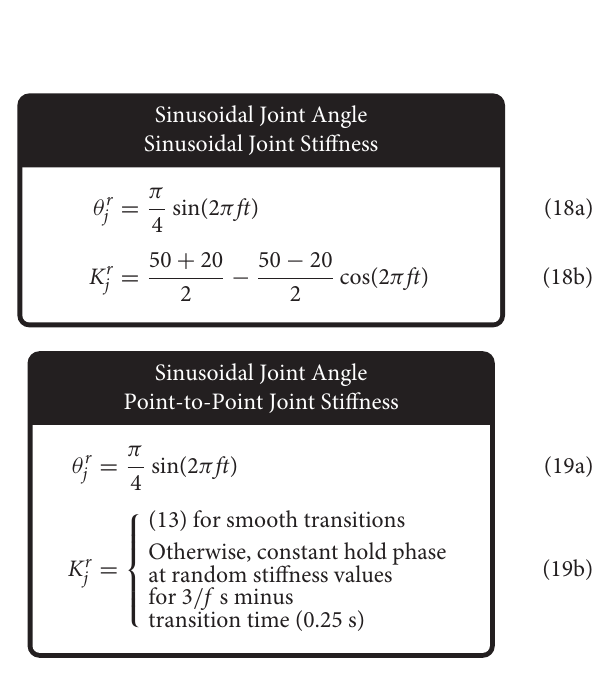
FIGURE 6 | Proposed experimental setup for a single choice of either babbling duration (Experiment 1, N = 25) or the number of hidden-layer nodes (Experiment 2, N = 10). For either experiment, for each choice of the independent parameter, N motor babbling experiments were conducted and N ANNs were trained (see Figure 4 ). The performance of each of these networks was determined by its ability to generalize to different movements [where joint angle and/or stiffness are prescribed either sinusoidal (Sin) or point-to-point (P2P) trajectories; See Figure 5 ]. A feedback linearization controller then calculated the input torques needed to produce the desired movements (see Palli et al., 2008 or Hagen et al., 2020), which were then passed through the plant to produce the experimental joint angle ( θ j ,exp ) as well as the four sensory sets of interest ( E x i sens ). These sets were then passed through their corresponding ANNs (that were trained with babbling data) to predict joint angle ( θ i j ,pred ). The prediction errors for each network were then averaged over all trials, and the performance as a function of the independent parameter could then be